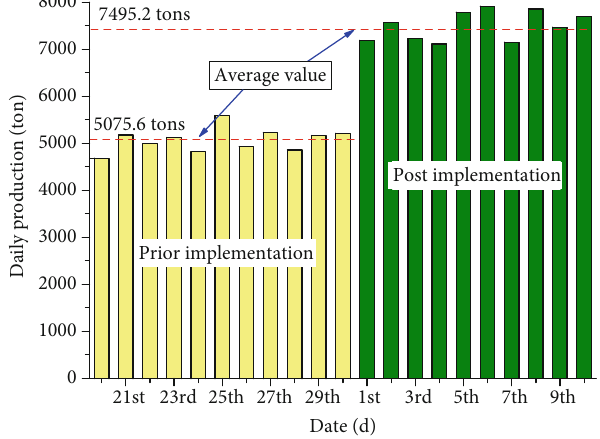
Figure 8: Characteristics of daily coal production at the working